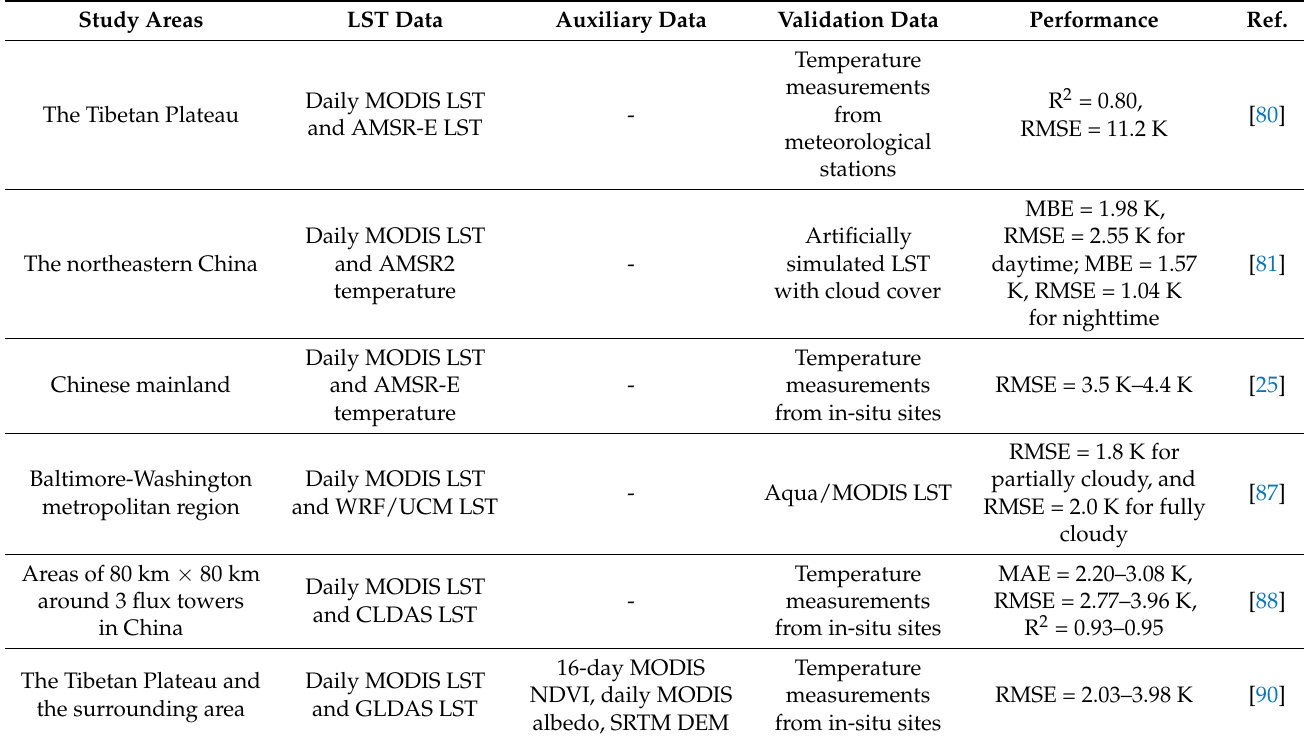
Table 7. Summary of multi-source fusion-based gap-filling